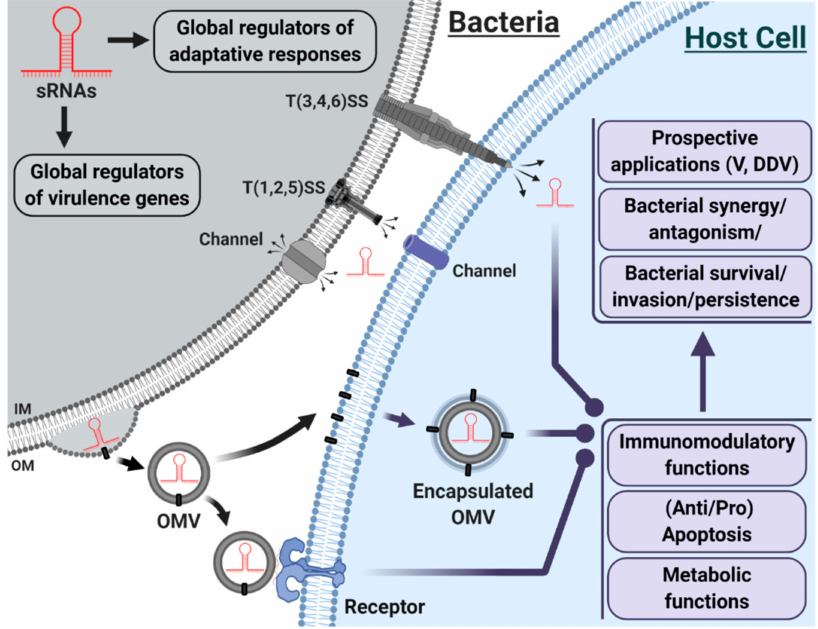
Figure 1. Schematic representation of bacterial host-pathogen interactions, with an emphasis on sRNAs.